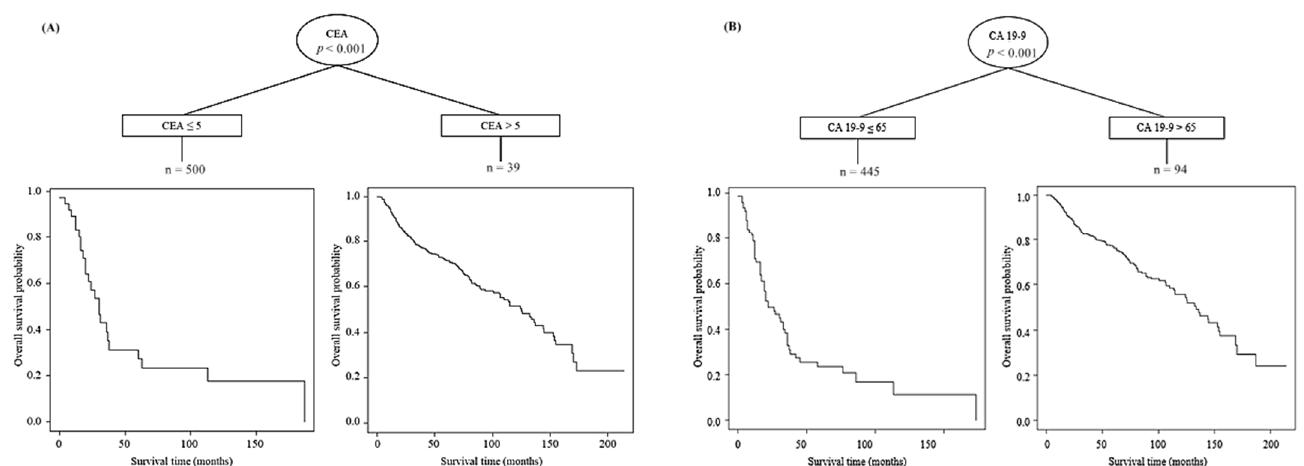
Figure 2. Analysis of ideal cut off value of CEA ( A ) and CA 19-9 ( B ) through C-tree method. Cut off value of CEA was 5 IU/mL and CA 19-9 was 65 IU/mL.